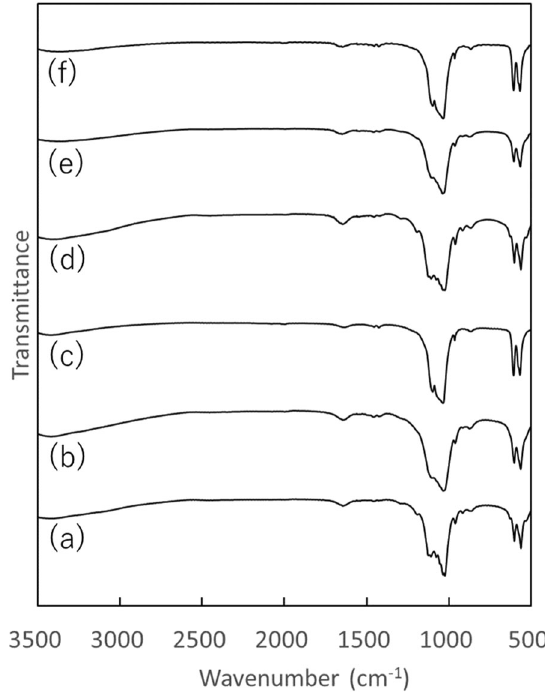
Fig. 4 FT-IR spectra of calcium phosphates with F – ion included in